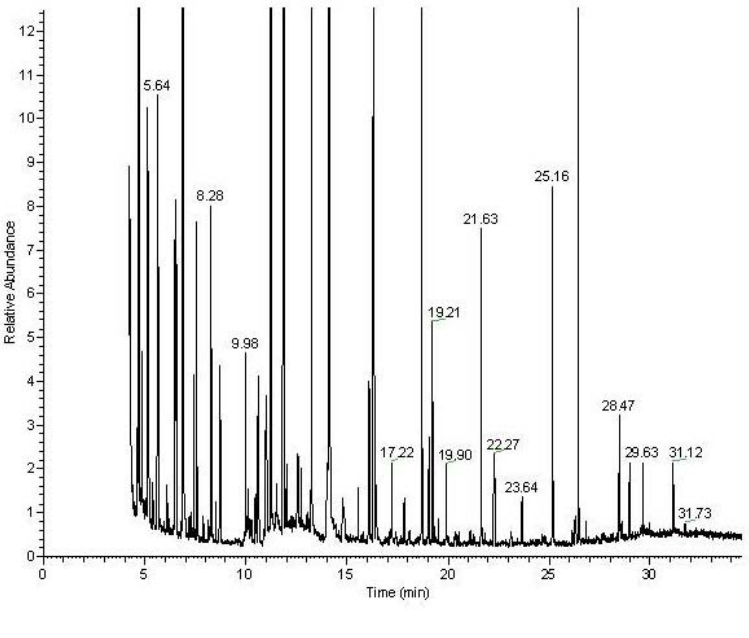
Figure 2. Typical GC-MS chromatogram of the MSTFA derivatized metabolites from the aqueous fraction of the heart tissue.